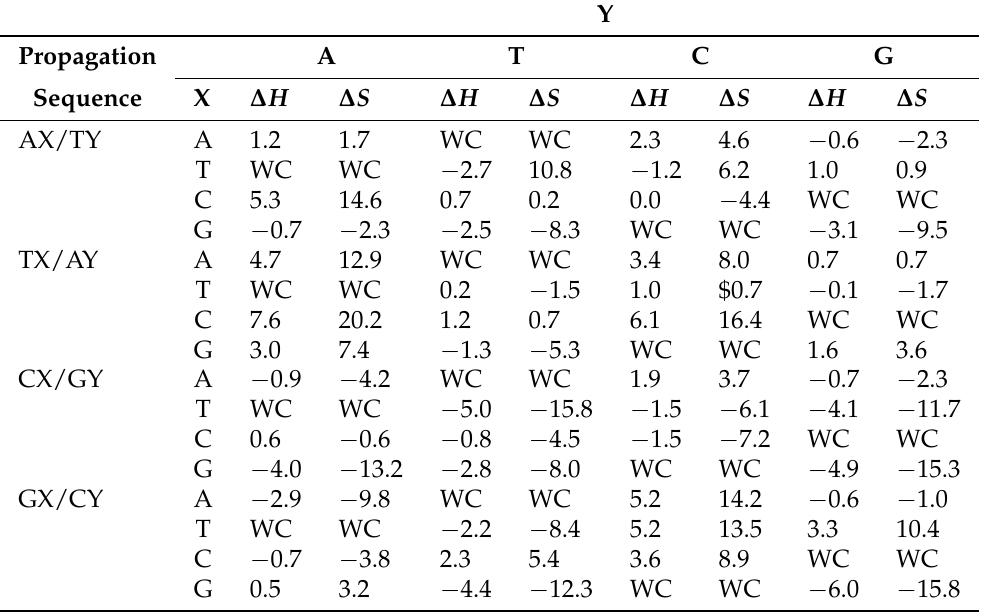
Table A3. Thermodynamic parameters for internal errors for DNA/DNA interaction. Energy and entropy units are kcal mol − 1 and cal mol − 1 K − 1 ,